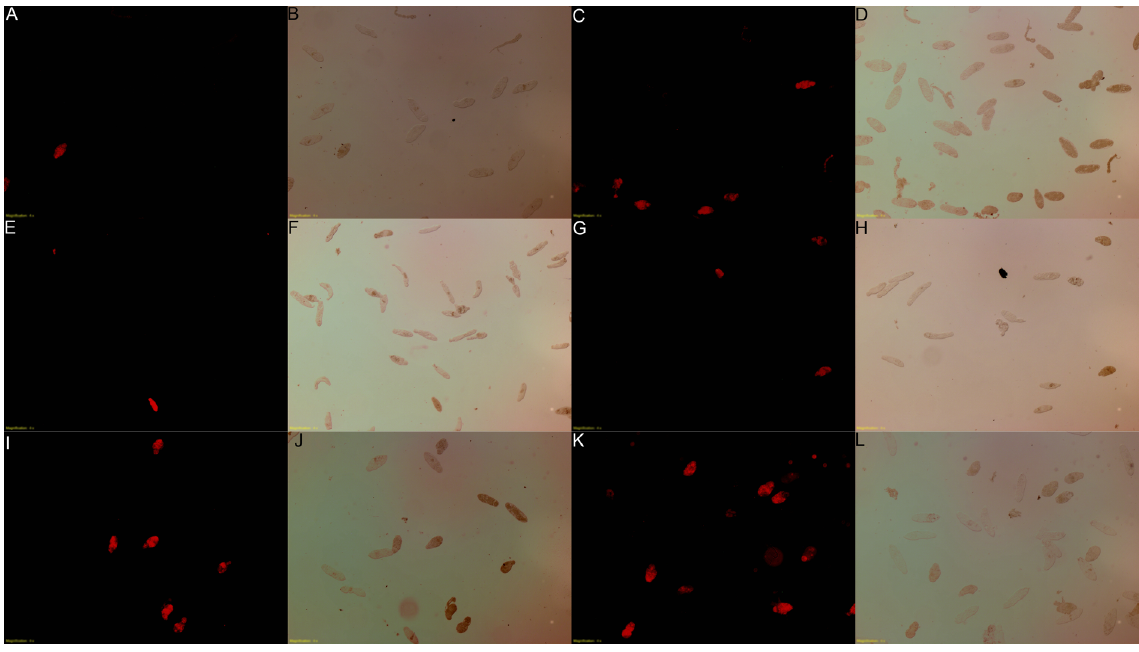
Figure 10. Assessment of 7-day schistosomula viability with propidium iodide. At 7-days, schistosomula were stained with 2 m g/mL propidium iodide and observed under a microscope with either polarized light or a rhodamine filter (536 nm). Dead parasites fluoresce under the rhodamine filter. Schistosomula were cultured in the Basch medium with PEI agent alone (A–D), transfected with plasmid constructs expressing mCherry under control of SmActin1 promoter (E–H), or transfected with plasmid constructs expressing SmCaspase7 under control of SmActin1 promoter (I–L). (A), (C), (E), (G), (I), (K) were detected by a rhodamine filter. (B, D, F, H, I, L) were the corresponding samples visualized by polarized light. Images were obtained under 40X magnification.